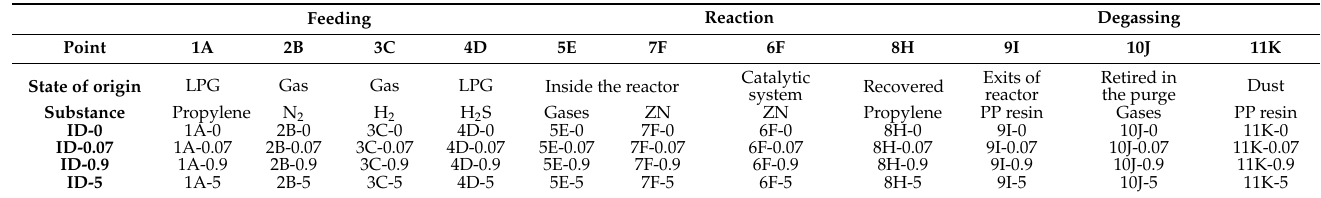
Table 1. Identification of samples and sampling points.